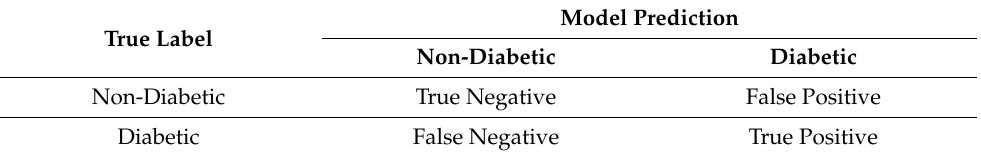
Table 2. Confusion